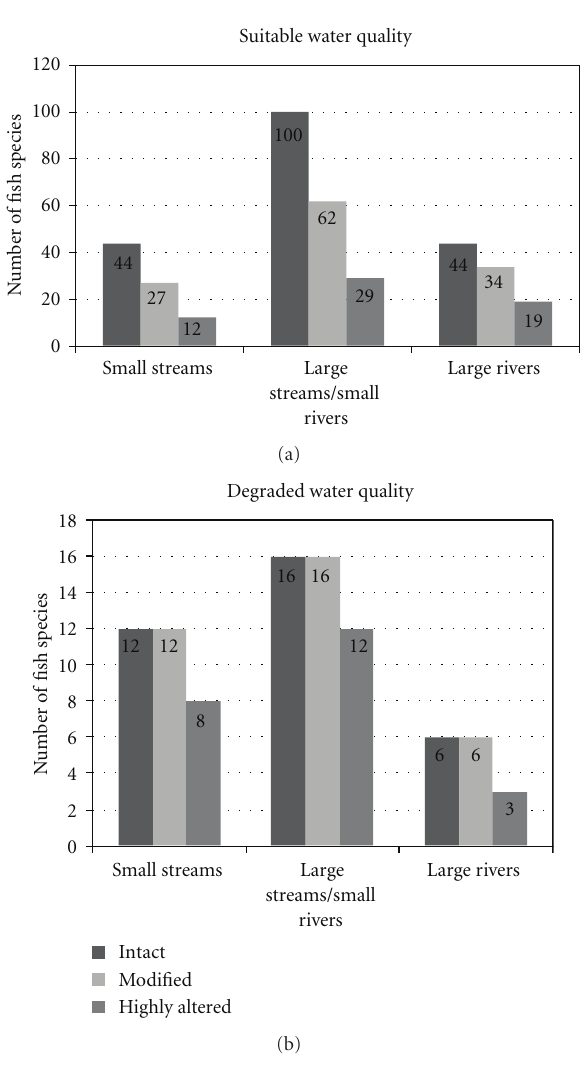
Figure 2: Predicted number of fish species by habitat type.